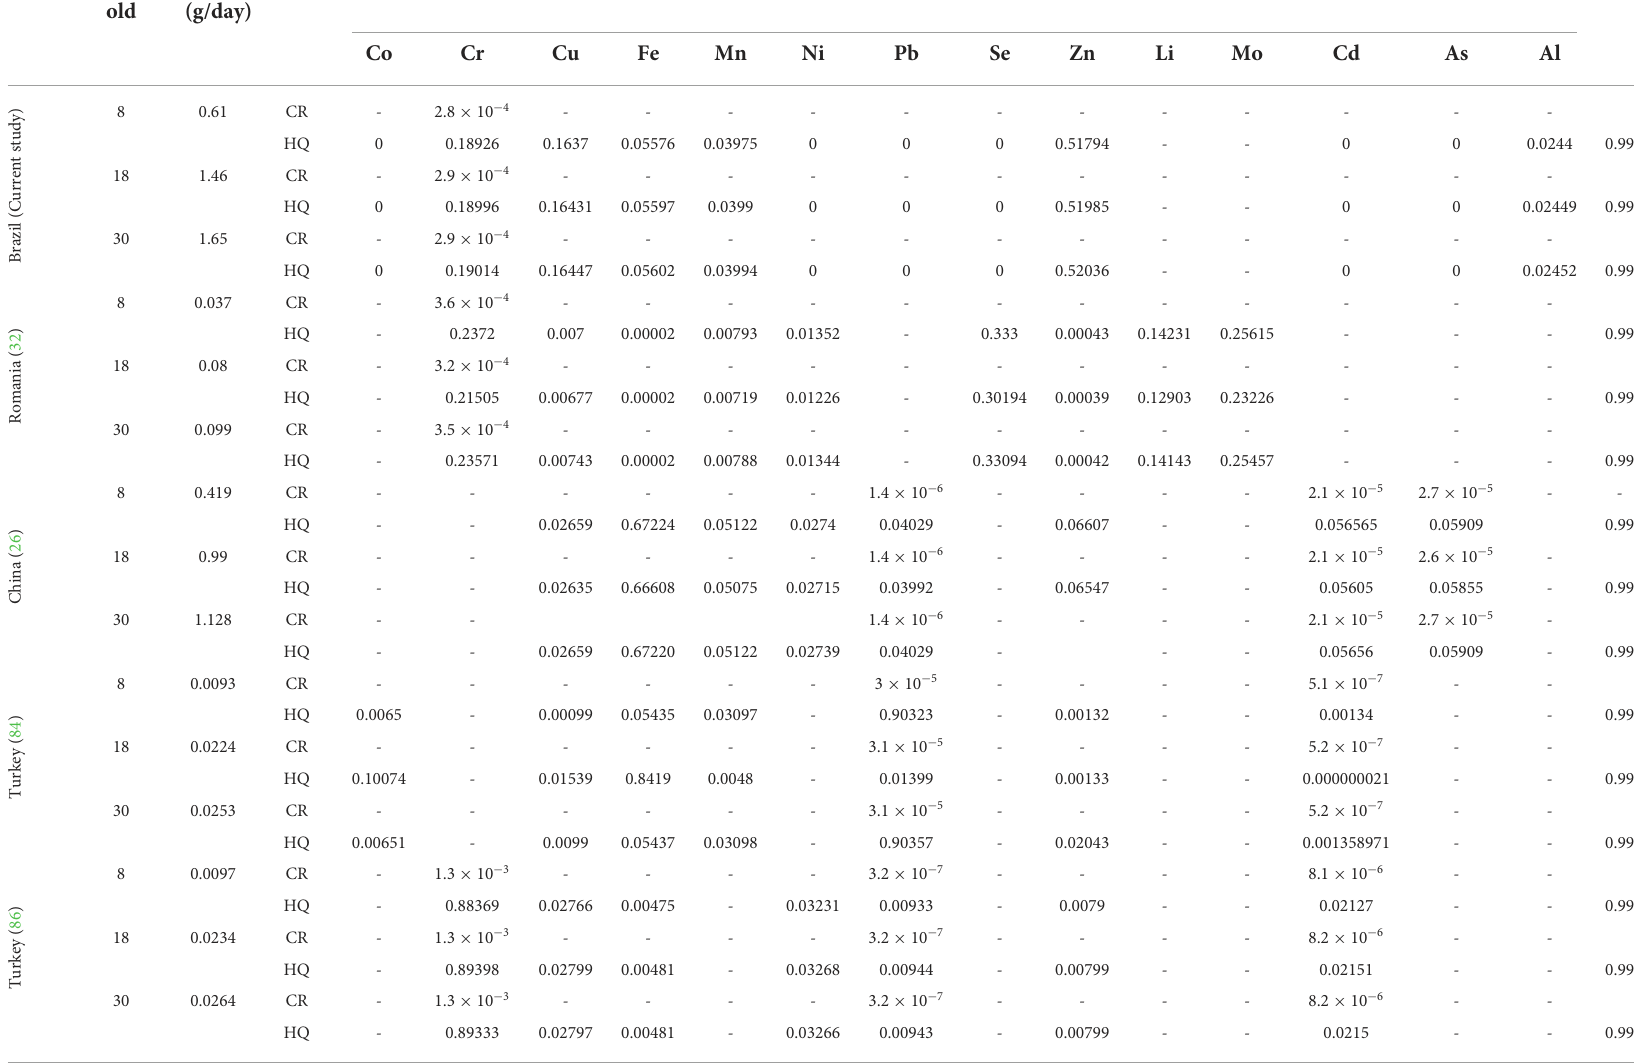
TABLE 6 Non-carcinogenic risk (CR), hazard quotient (HQ), and total non-carcinogenic hazard index (HI) of trace elements on ingestion rate (IR g/kg) of sunflower oil obtained by cold-press (Brazil and Romania) and commercially available (China and Turkey).